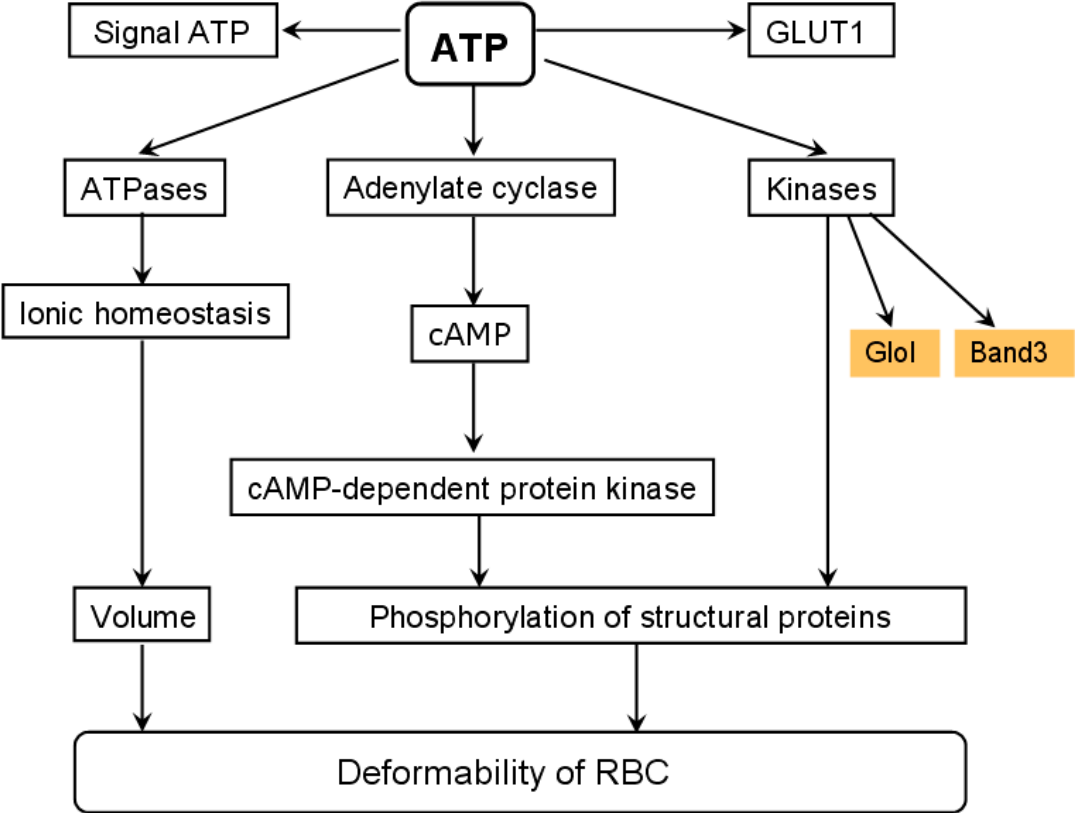
Figure 3. ATP-regulated processes in red blood cells. cAMP—cyclic AMP, Glo1—glyoxalase I, Band3—RBC membrane anion transporter protein (band 3 protein).